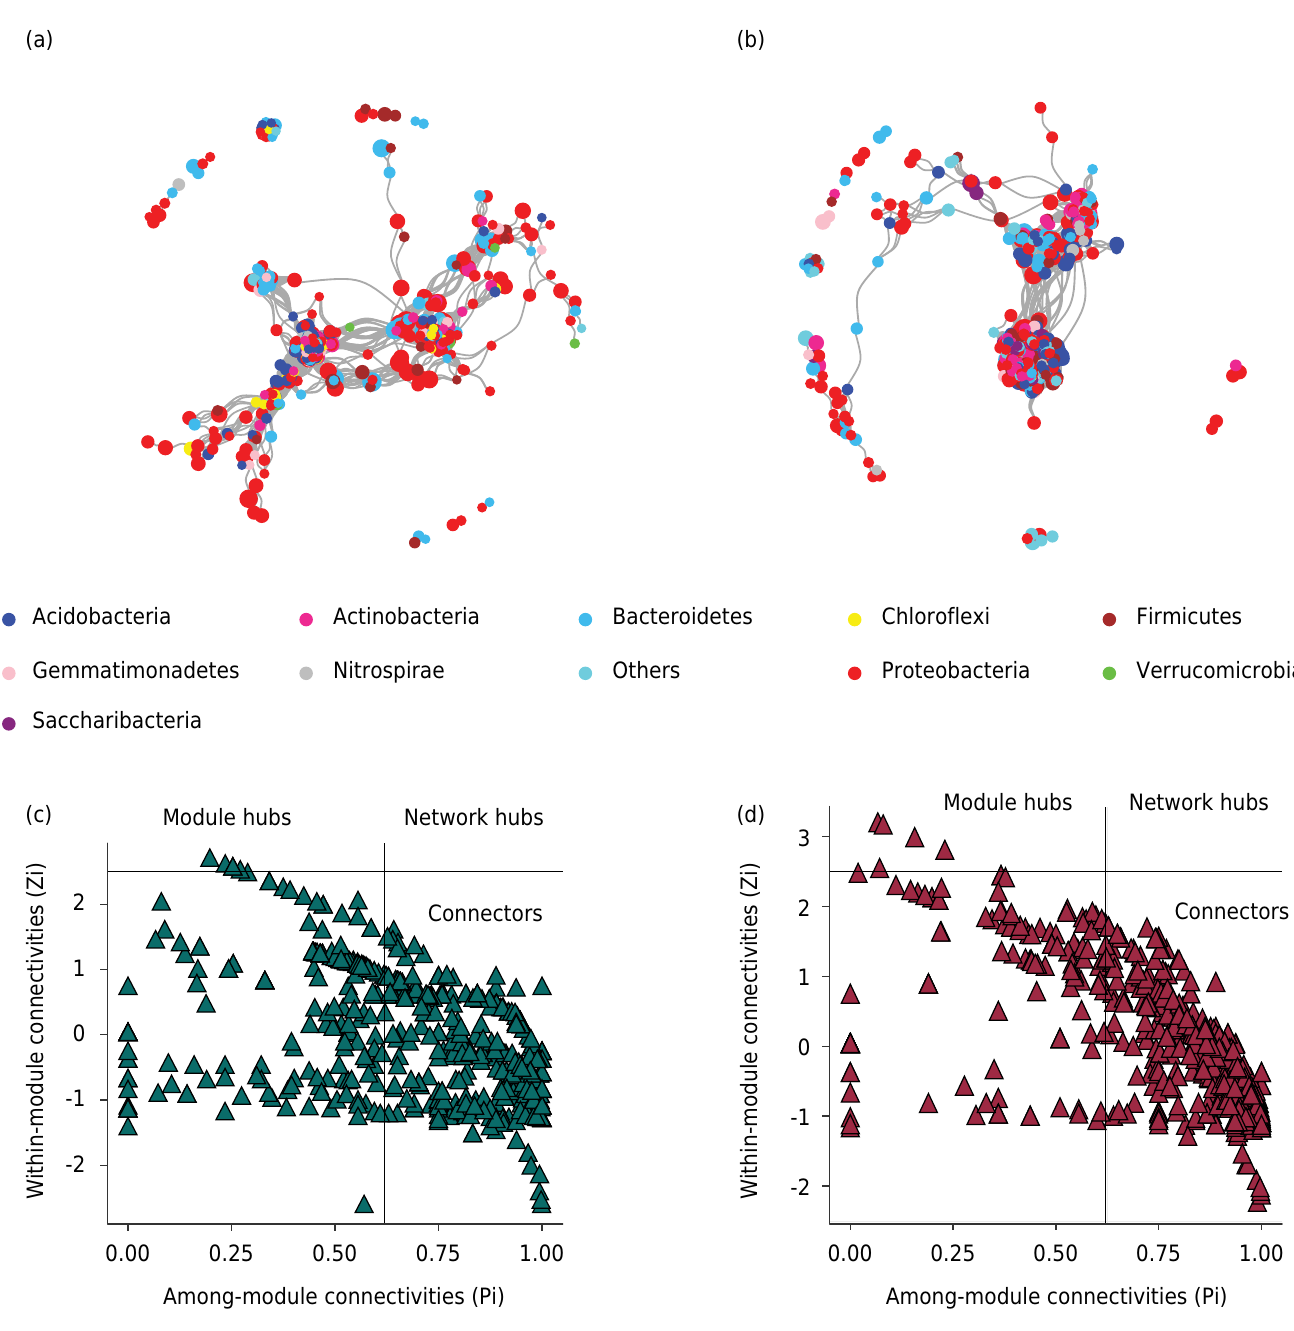
Figure 3. Co-occurrence network of soil bacteria dominant OTUs. In terms of the co-occurrence networks of the soil bacterial community under CS+SAS treatment (a) and BCS+BSAS treatment (b), the node size in each network was proportional to its relative abundance. The ZI-PI diagram showed the distribution of significant OTUs of soil bacteria based on their topological properties under the CS+SAS (c) and BCS+BSAS (d)